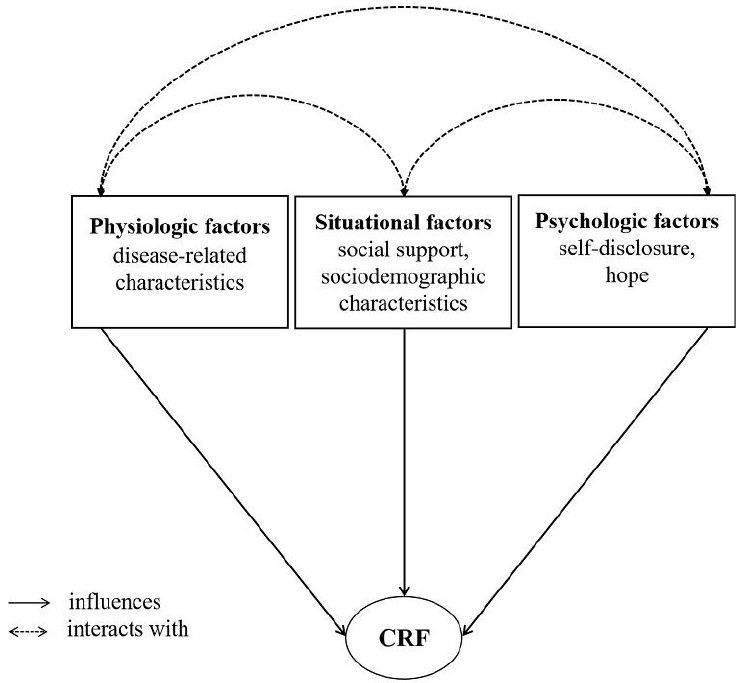
Figure 1. The hypothesized model on influencing factors of CRF in patients with colorectal cancer. Note: CRF, cancer-related fatigue.